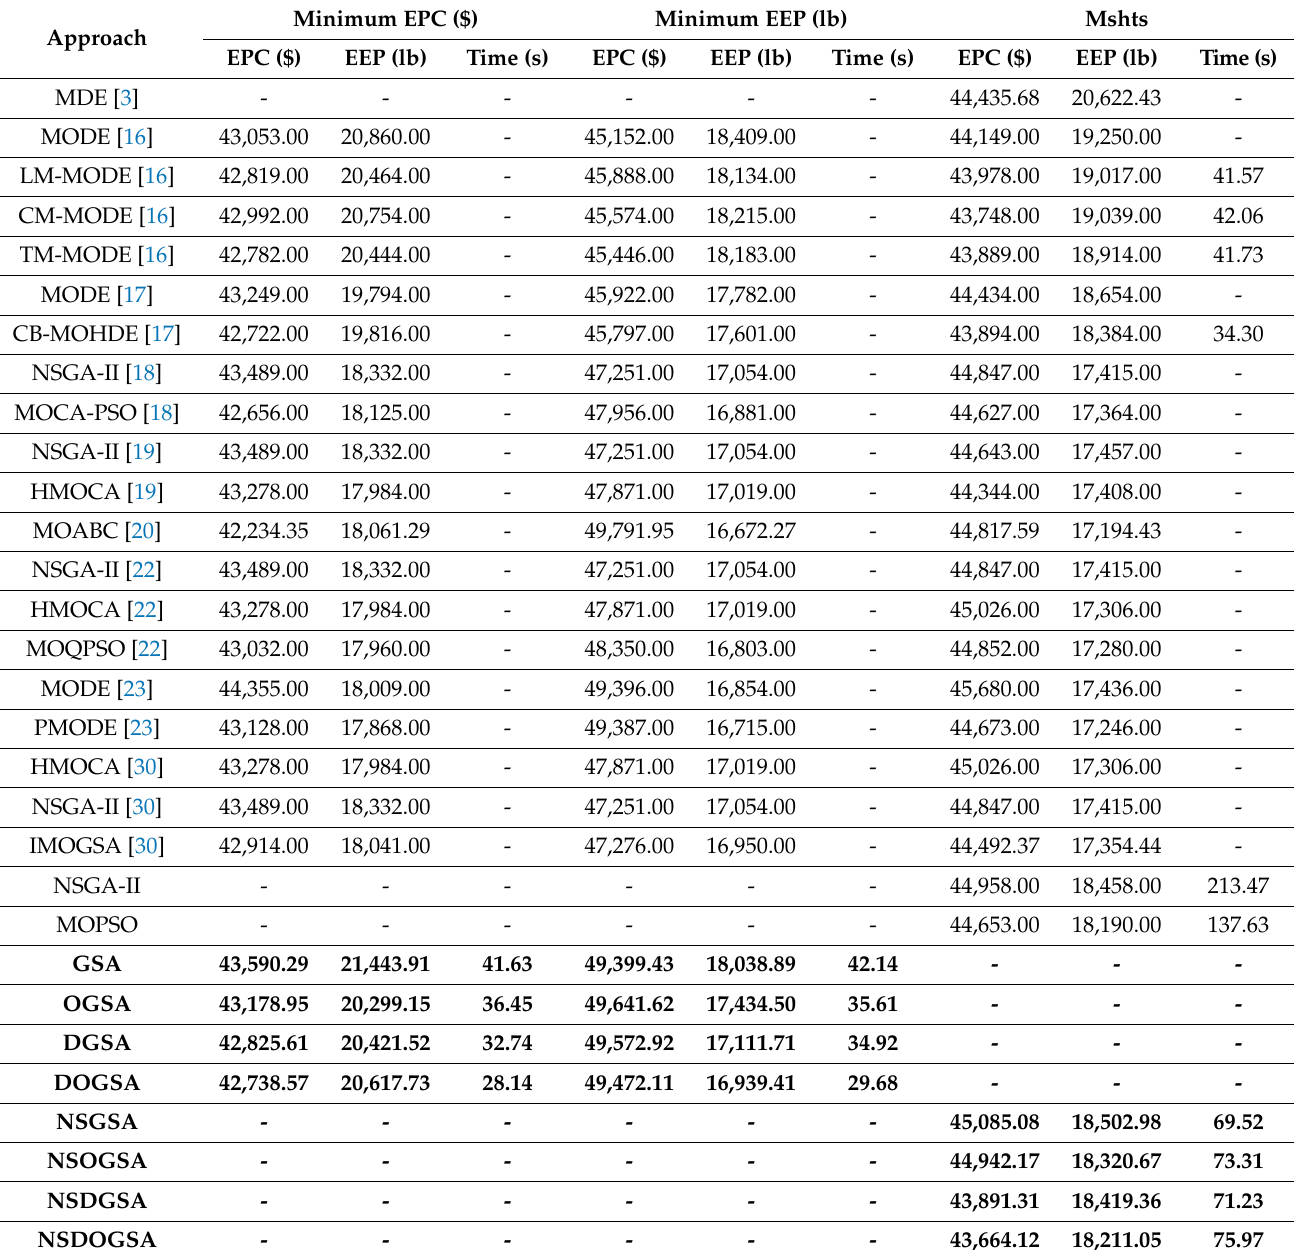
Table 6. Performance evaluation of Test System-II’s multiple approaches.